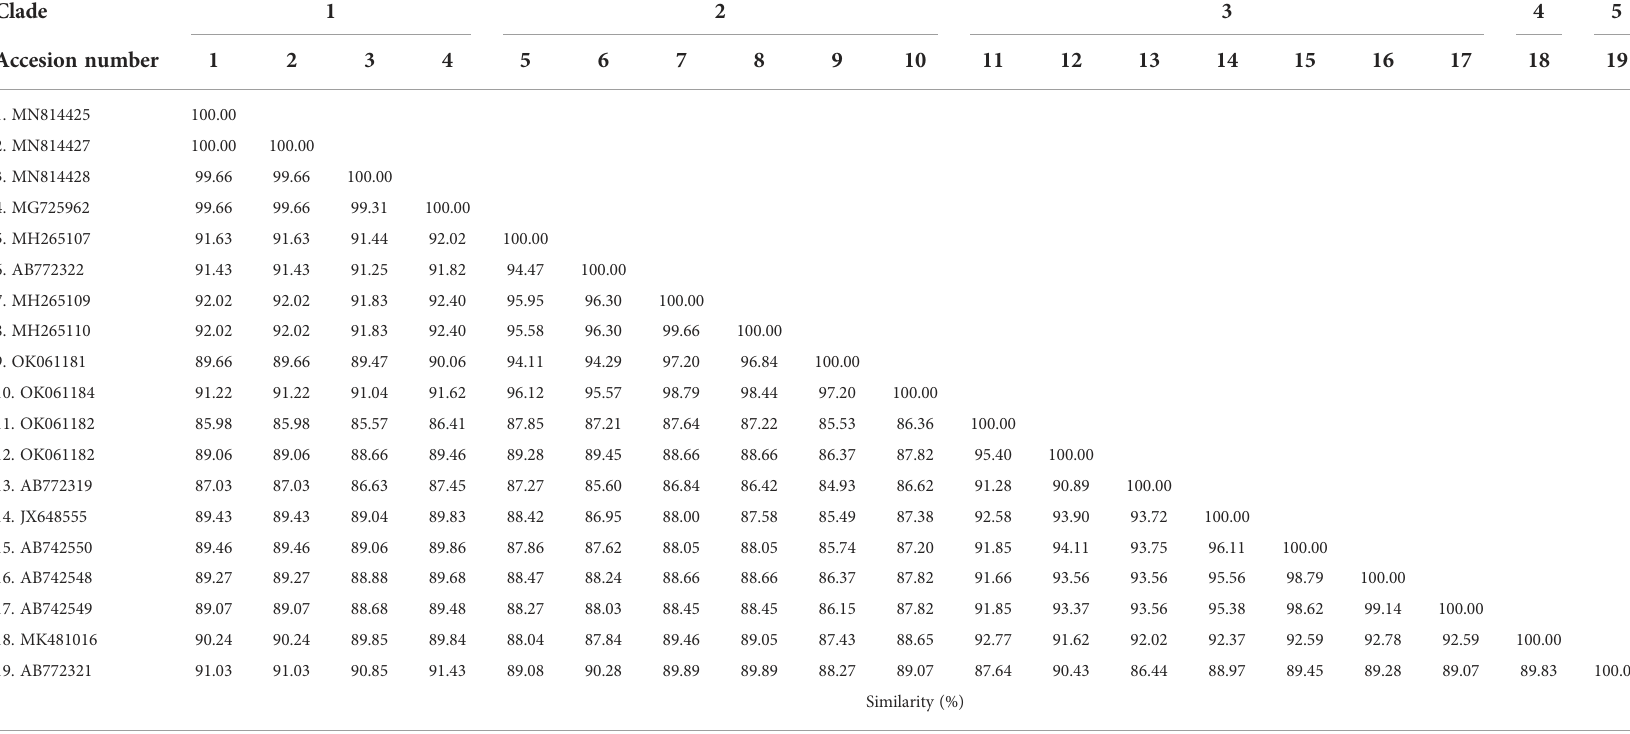
TABLE 2 Similarity of the B. bovis sbp-2 gene sequences as examined in cattle samples in Thailand and other countries. Clade Accesion